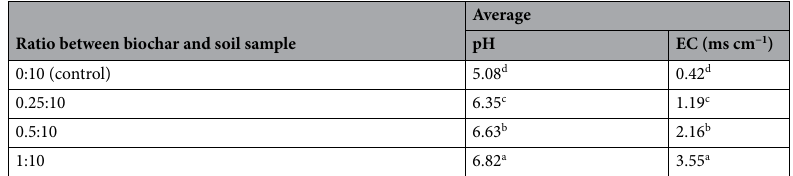
Table 3. Average of pH and EC of the soil mixtures containing different ratios of biochar to soil sample collected from Klong 4, 5, and 6 (different lowercase letters in the column indicate significant differences at the P < 0.05 level following two-way ANOVA analysis and DMRT).